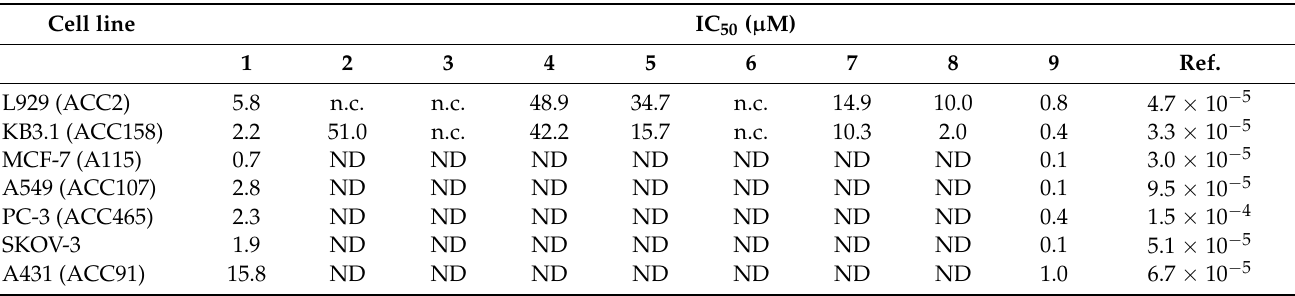
Table 6. Cytotoxic activities of compounds 1 – 9